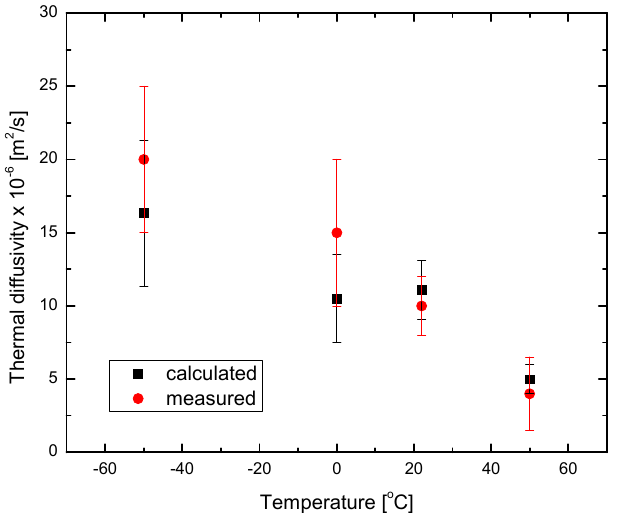
Figure 10. Relation between measured and calculated values of thermal diffusivity as function of temperature.